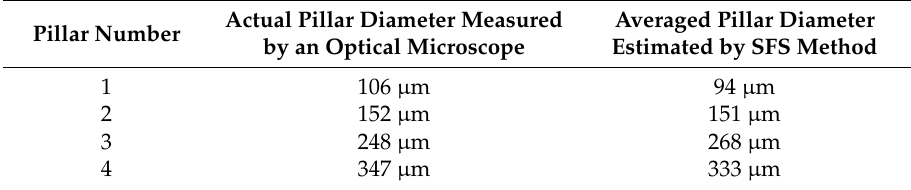
Figure 6. 3D shape reconstruction of a 3D printed pillar array model made of acrylate-based resin. ( a ) optical microscope image; ( b ) silhouette obtained using UV illumination; ( c ) reconstruction of the pillar array model using a shape from silhouette method; and ( d ) a cross section at half the height of each reconstructed pillar. Table 1. Diameter of each pillar of a 3D printed pillar array model.